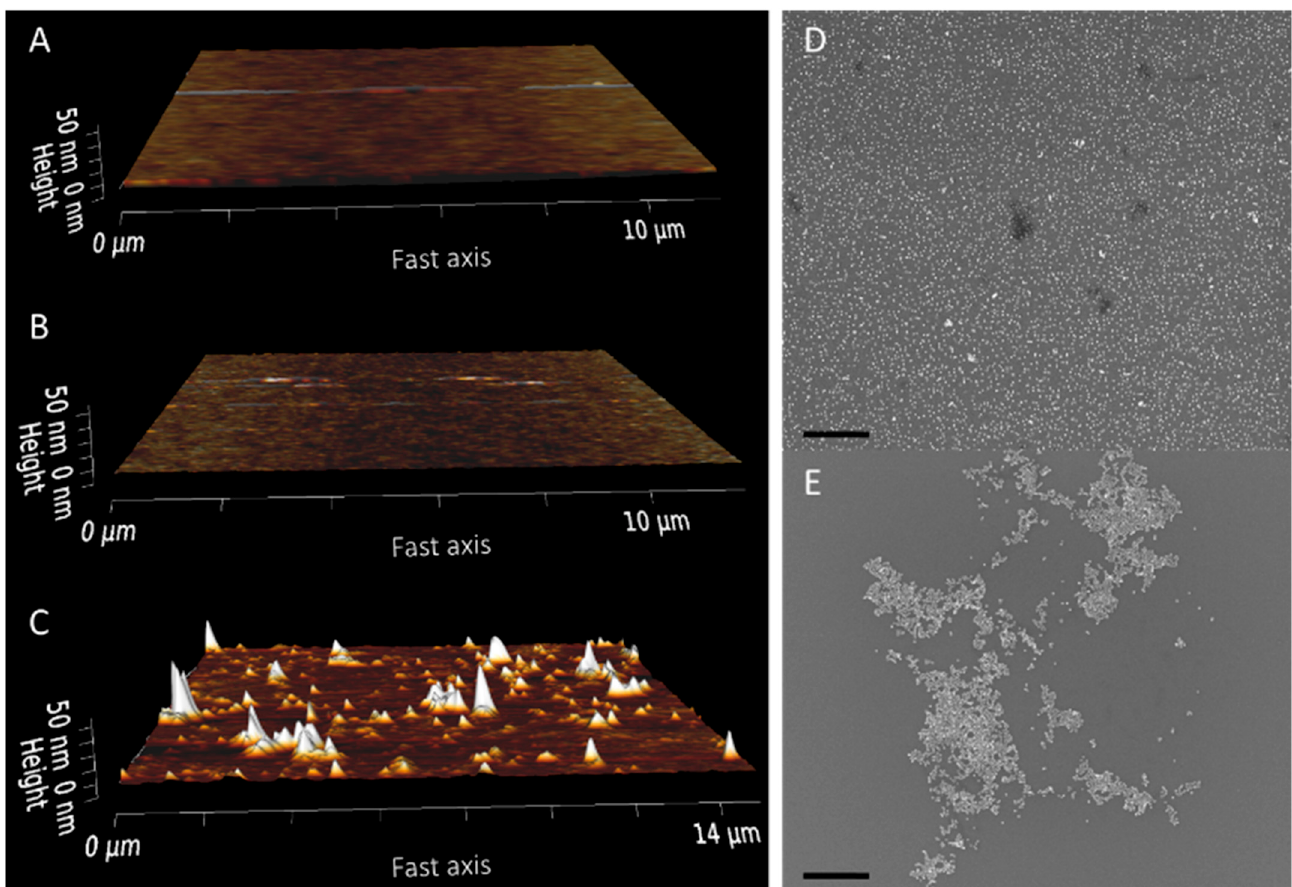
Figure 1. Aminosilane functionalization of silicon wafer segments and subsequent gold nanoparticle deposition. AFM images of a blank wafer ( A ) and wafer segments after AAPTMS ( B ) and APS ( C ) functionalization. Representative SEM images of AAPTMS ( D ) and APS ( E ) functionalized surfaces after deposition of 10 nm gold nanoparticles. Scale bar = 500 nm.